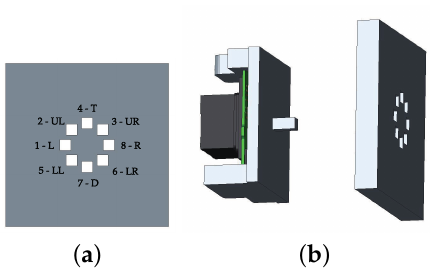
Figure 6. 3D CAD of the mounting template used for placing the viewpoint camera in eight different positions within the eye-motion-box of the see-through display. ( a ) The eight fixing holes for camera positioning. ( b ) The mounting